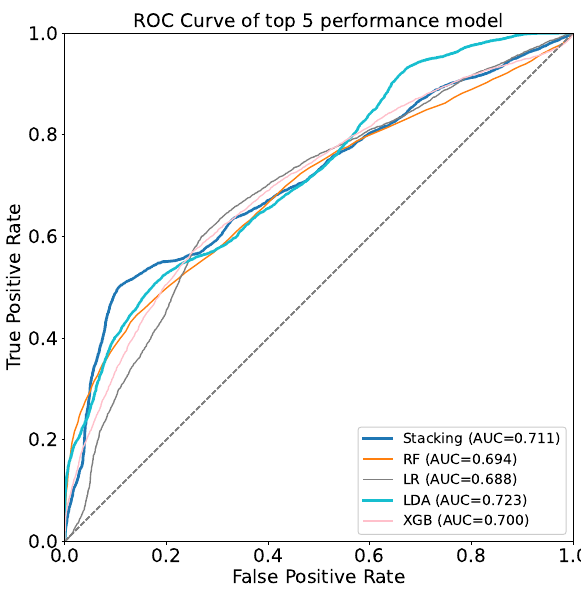
Figure 3. The ROC curve of the top-5 performance models. RF denotes Random Forest Classifier; LR denotes Logistic Regression; LDA denotes Linear Discriminant Analysis; XGB denotes XGB Classifier.